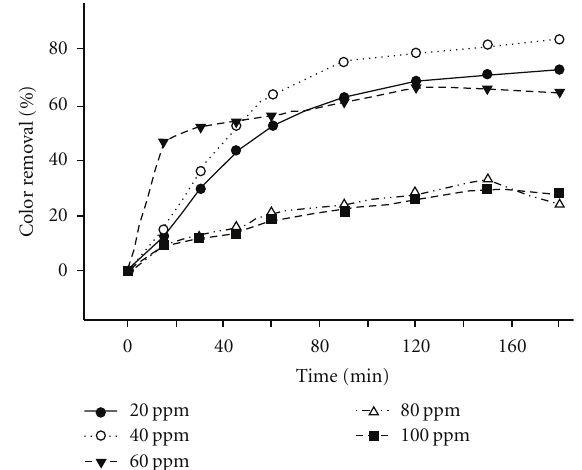
Figure 7: The e ff ect of dye concentration on the photodegradation methyl green [Fe-OP-NCY] = 1gL − 1 , pH = 5.2, T = 25 ◦ C.